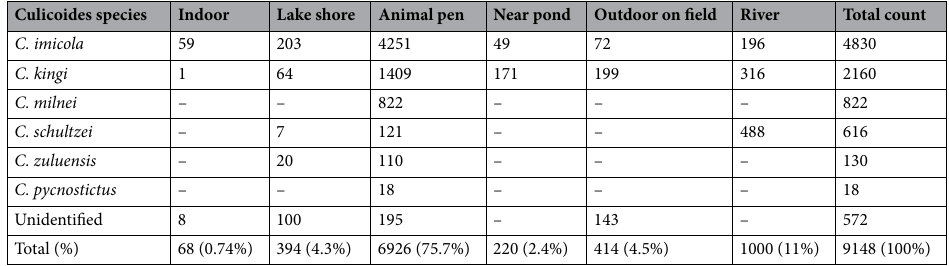
Table 3. Culicoides species collected from different